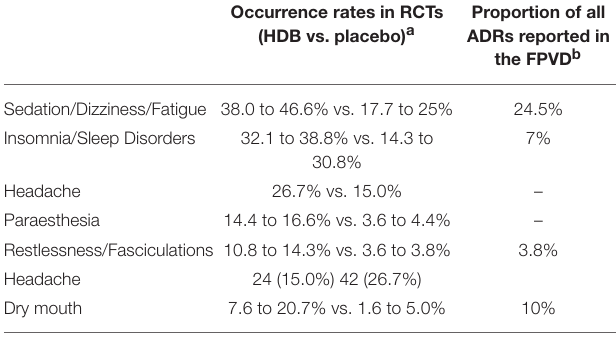
TABLE 1 | Main ADRs occurring in AUD patients treated with high dose baclofen.